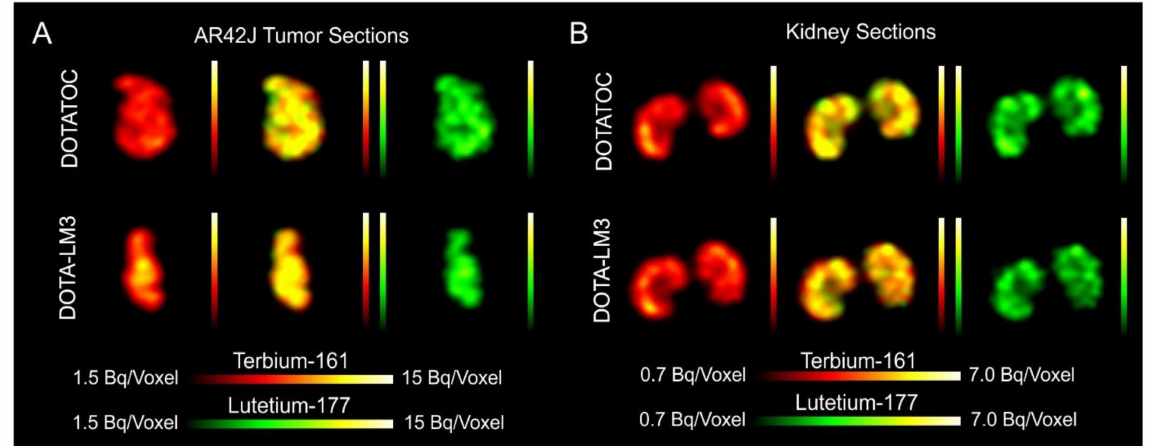
Figure 5. Dual-isotope SPECT images shown as coronal sections of AR42J tumors and kidneys. ( A ) Images of AR42J-tumors and ( B ) Images of the kidneys of mice 2 h p.i. of the radiopeptides. Mice were injected with a mixture of [ 161 Tb]Tb- DOTATOC and [ 177 Lu]Lu-DOTATOC (upper panel) or a mixture of [ 161 Tb]Tb-DOTA-LM3 and [ 177 Lu]Lu-DOTA-LM3 (lower panel). Reconstructions based on X-rays or γ -rays of terbium-161 (left); Reconstructions based on X-rays or γ -rays of terbium-161 and on the γ -rays of lutetium-177 (middle); reconstructions based on the γ -rays of lutetium-177 (right).